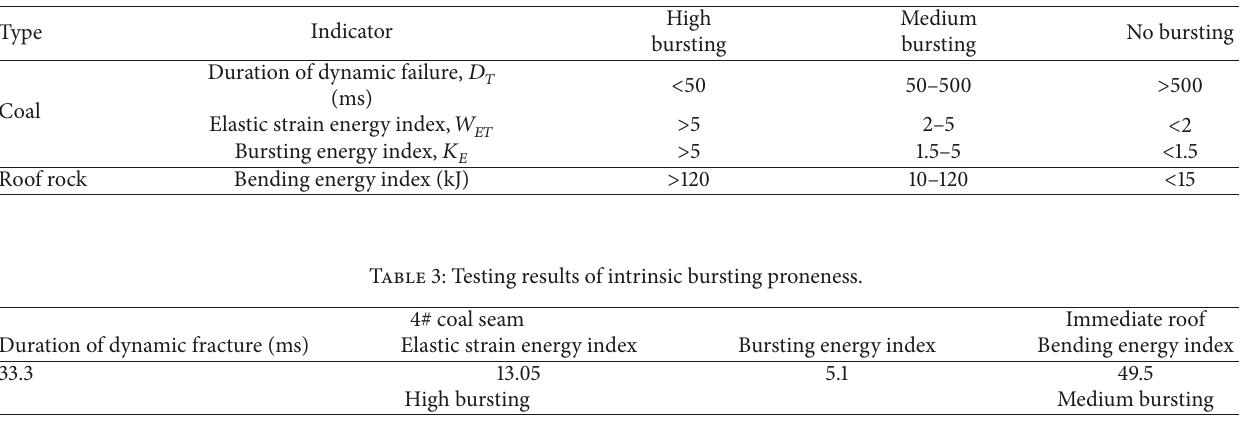
Table 2: Classification of the bursting proneness of coal and rock.